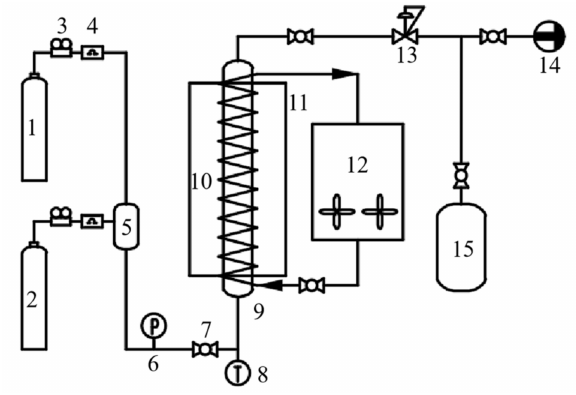
Figure 2. Adsorption system: (1) N 2 ; (2) blended gases; (3) pressure reducing valve; (4) mass flow meters; (5) buffer tanks; (6) pressure gauge; (7) valve; (8) thermocouple; (9) adsorptive column; (10) refrigerant coils; (11) heating jackets; (12) circulating refrigeration pumps; (13) back pressure valve; (14) sampling port; and (15) exhaust gas tank.